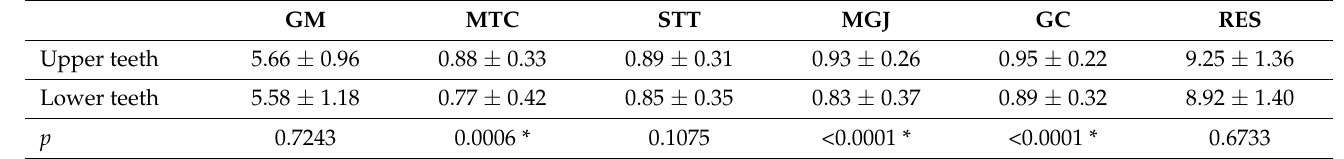
Table 3. Evaluation of aesthetic outcomes after 12 months (mean and standard